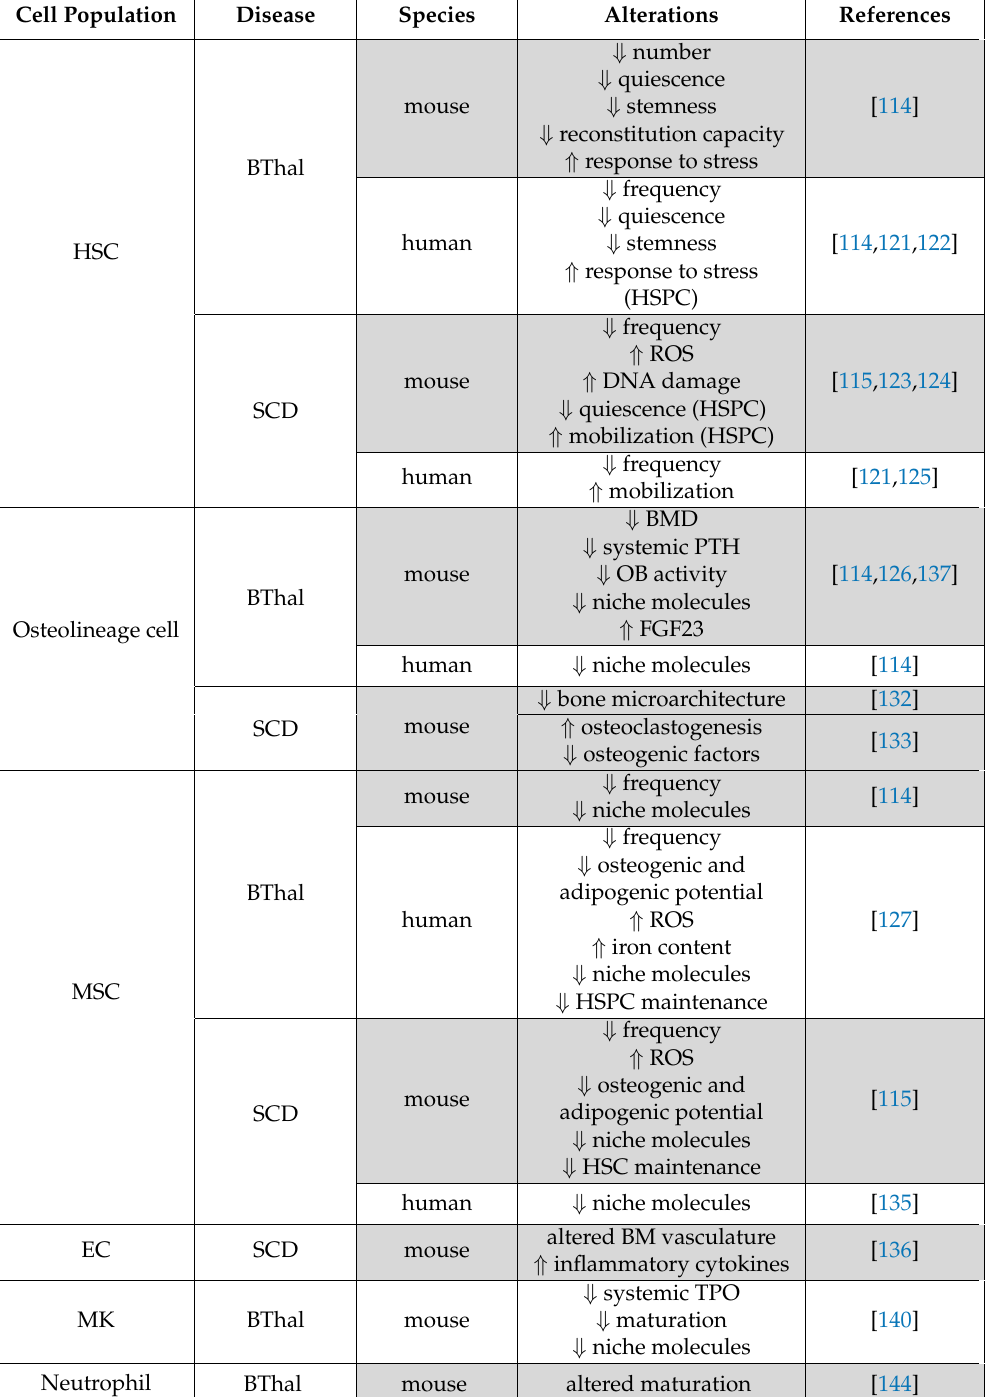
Table 1. Altered BM niche populations in BThal and SCD. Alterations are shown as increased ( ⇑ ) or decreased ( ⇓ ) levels of specific features in BM niche